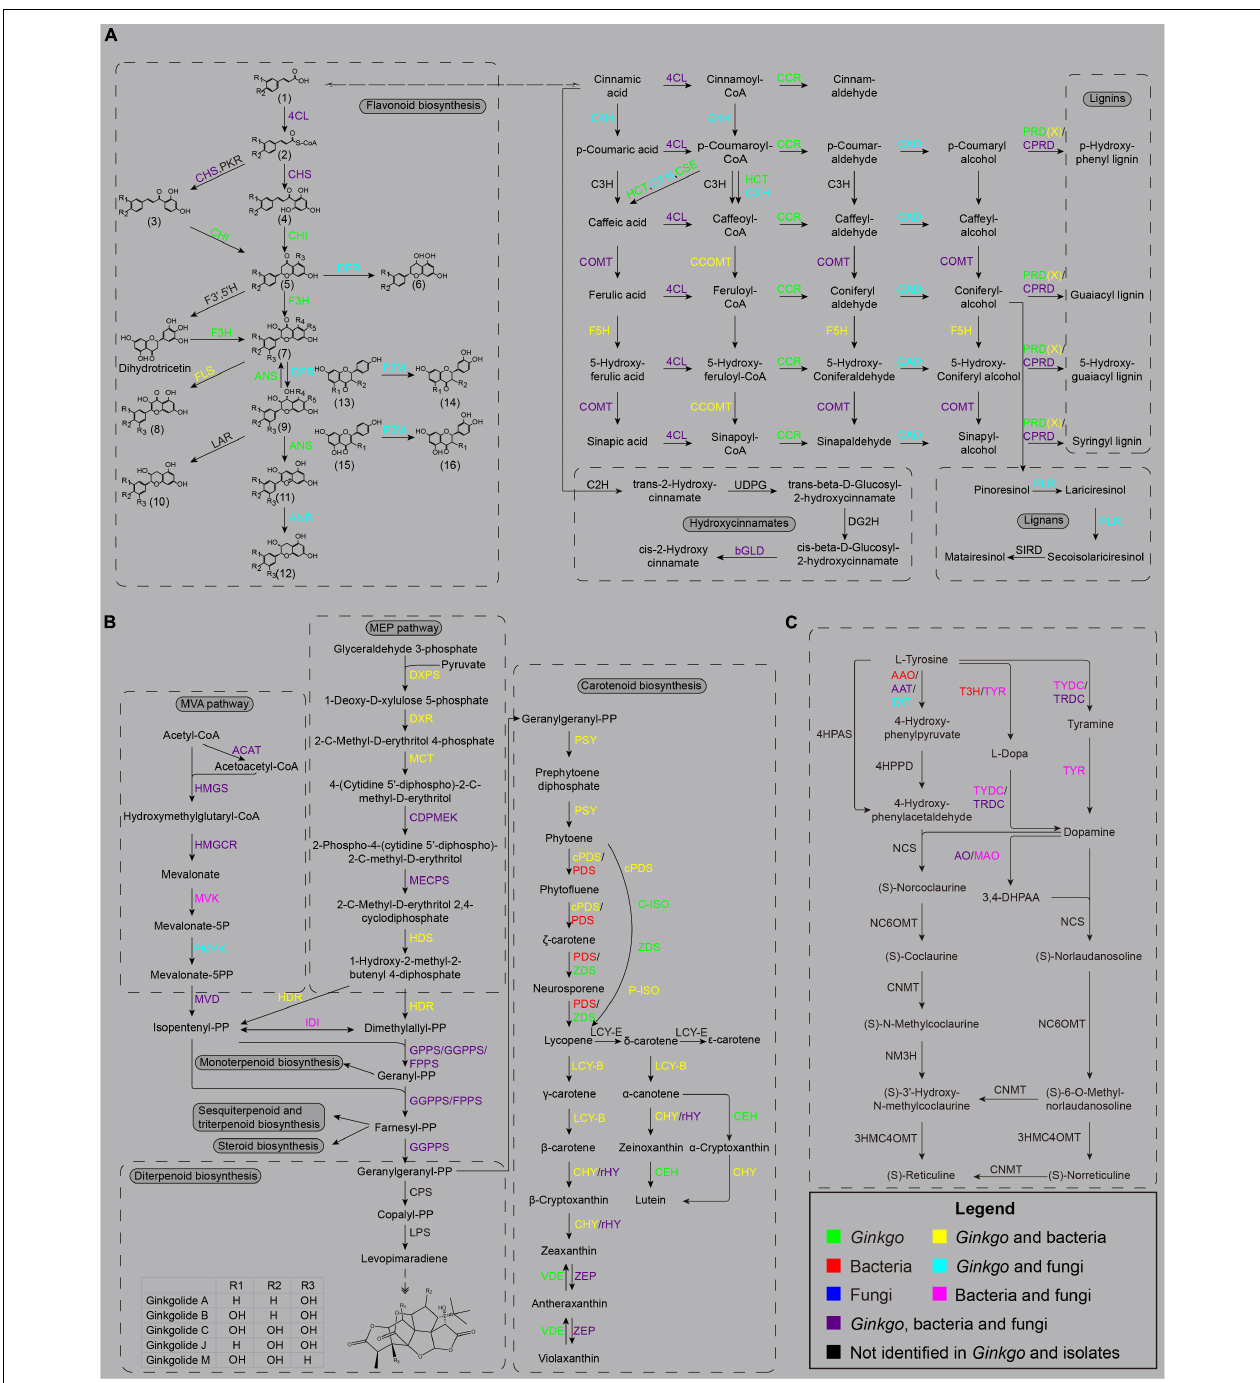
FIGURE 4 | The main secondary metabolism pathways. (A) The biosynthesis sketch of flavonoid and non-flavonoid polyphenolics in the Ginkgo root community. The R labels represent a hydrogen atom, a hydroxyl, or a methoxy in all chemical structures. (1) trans -cinnamic acid; p -coumaric acid; caffeic acid; ferulic acid; (2) cinnamoyl-CoA; p -coumaroyl-CoA; caffeoyl-CoA; (3) isoliquiritigenin; butein; (4) pinocembrin chalcone; naringenin chalcone; eriodictyol chalcone; (5) pinocembrin; liquiritigenin; butin; naringenin; eriodictyol; (6) apiforol; luteoforol; (7) pinobanksin; garbanzol; fustin; dihydrokaempferol; dihydroquercetin; dihydromyricetin; (8) galangin; kaempferol; quercetin; myricetin; (9) 5-deoxyleucopelargonidin; 5-deoxyleucocyanidin; cis -3, 4-leucopelargonidin; leucocyanidin; leucodelphinidin; (10) afzelechin; (+)-catechin; (+)-gallocatechin; (11) pelargonidin; cyanidin; delphinidin; (12) (–)-epiafzelechin; (–)-epicatechin; (–)-epigallocatechin; (13) liquiritigenin; garbanzol; naringenin; dihydrokaempferol; (14) butin; fustin; eriodictyol; dihydroquercetin; (15) apigenin; kaempferol; (16) luteolin; quercetin. (B) The biosynthesis sketch of terpenoid backbone and their derivatives in the Ginkgo root community. (C) The biosynthesis sketch of isoquinoline alkaloid backbone in the Ginkgo root